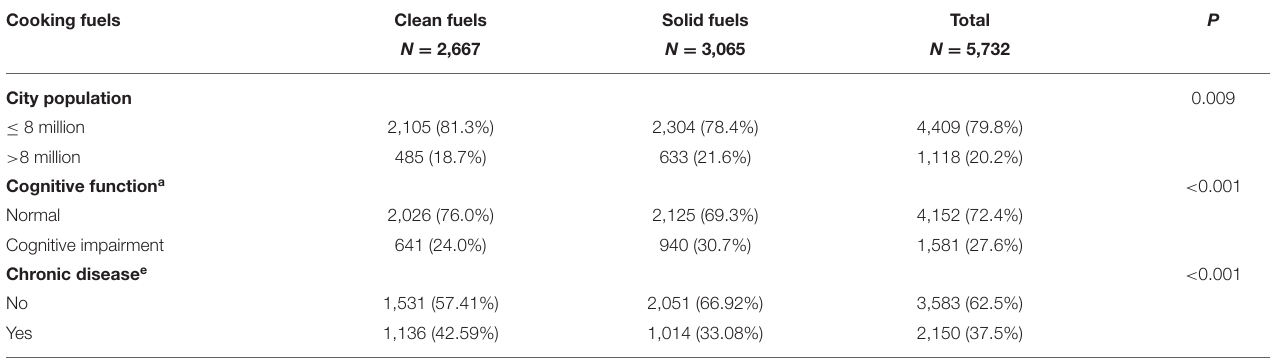
TABLE 3 | Association of the change of cooking fuels during 2011–2014 with 2018 mortality. Model Fuel